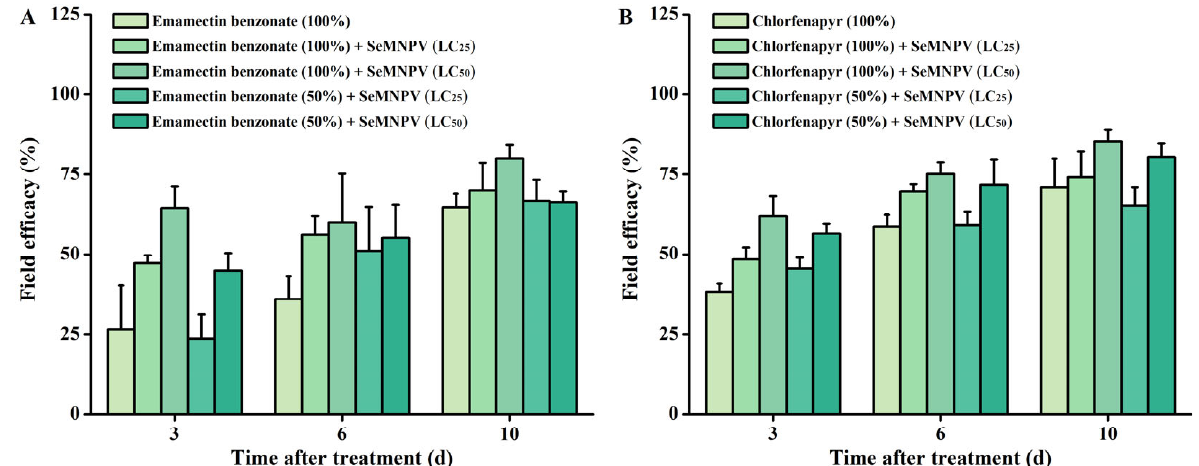
Figure 2. SeMNPV enhanced the field efficacy of emamectin benzonate and chlorfenapyr against S. exigua . The control efficacy of emamectin benzonate ( A ) and chlorfenapyr ( B ) with or without SeMNPV against S. exigua . Emamectin benzonate (100%) and emamectin benzonate (50%) represented 100% and 50% recommended dosage of emamectin benzonate. Chlorfenapyr (100%) and chlorfenapyr (50%) represented 100% and 50% recommended dosage of chlorfenapyr.